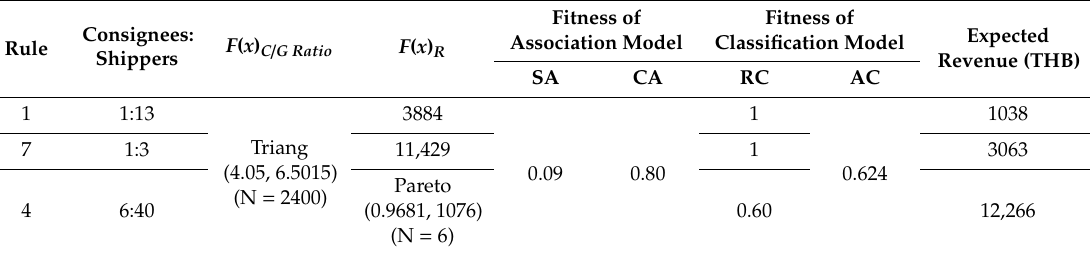
Table 8. Probability distribution functions of input